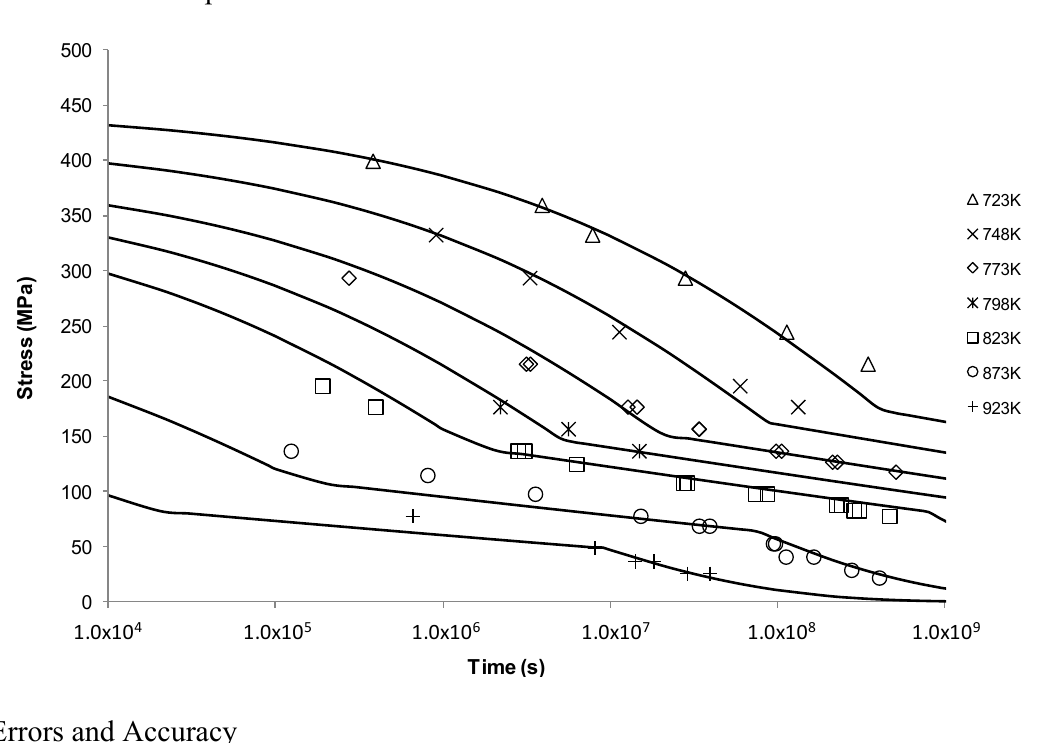
Figure 11. The Wilshire Equation’s stress vs . time to fracture predictive curves using Grade 22 Steel creep